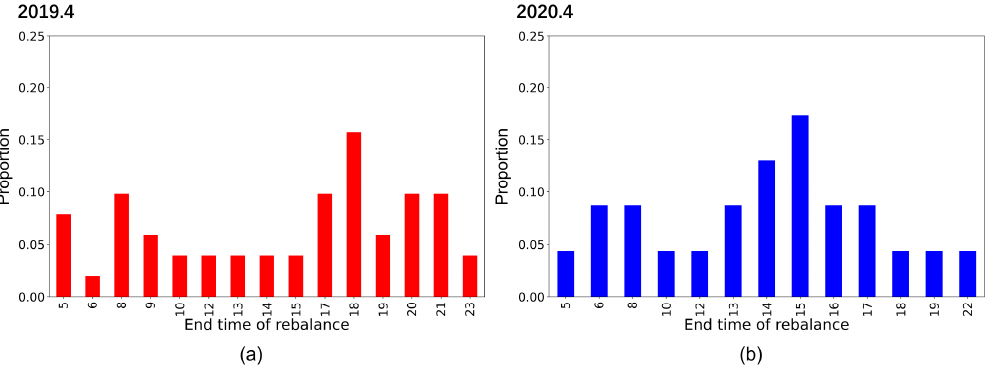
Figure 14. Statistics of the end time of rebalancing (rebalancing duration less than 10 min) ( a ) Statistics in 2019.4 ( b ) Statistics in 2020.4.